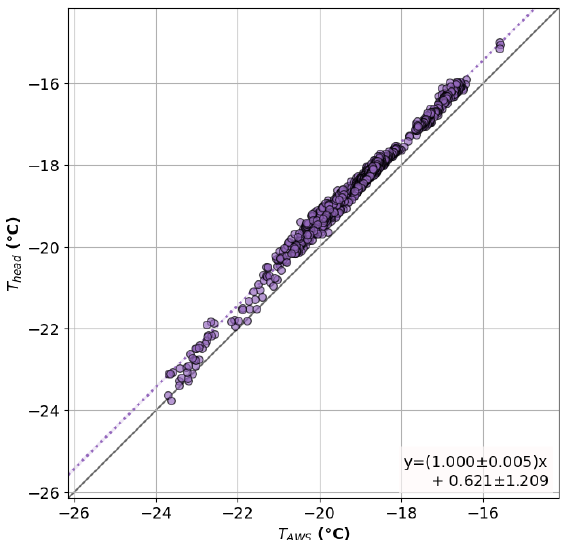
Figure C1. Comparison between the temperature sensor of the au- tomated weather station ( T AWS ) and the inlet temperature sensor ( T head ). Both were at a height of 100cm above the surface of the snow for 37h. Solid gray line represents 1-to-1 ratio. Dotted line in- dicates linear regressions through the data points, with purple shad- ing (barely visible under dotted line) showing the 95% confidence